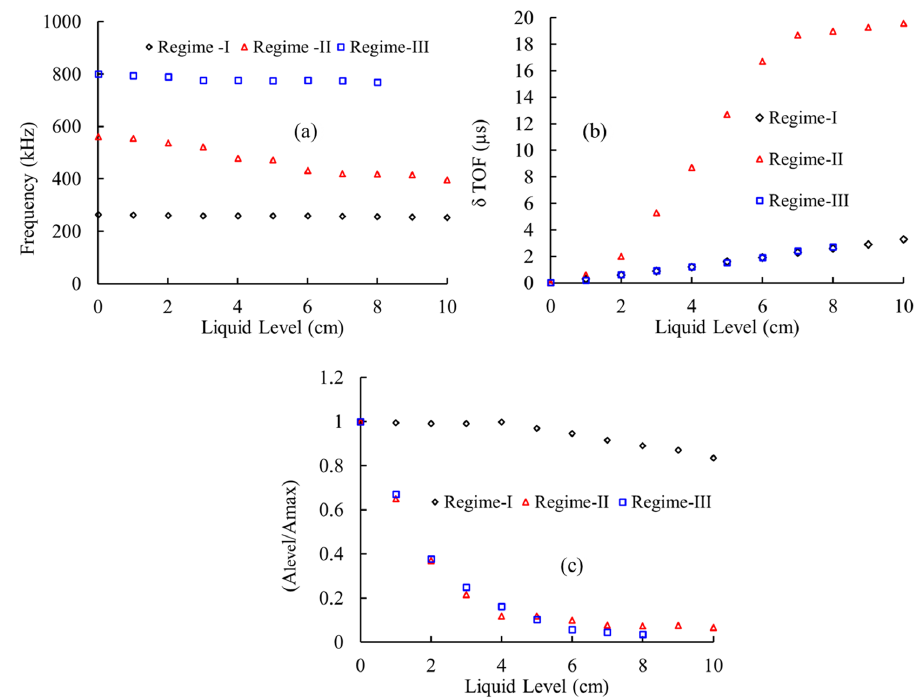
Figure 9. Illustrates the ( a ) shift in peak frequency, ( b ) change in time of flight ( δ TOF), and ( c ) drop in amplitude of F(1,1) wave modes at different fluid levels in Regime-I (250 kHz), Regime-II (500 kHz), and Regime-III (1000 kHz).